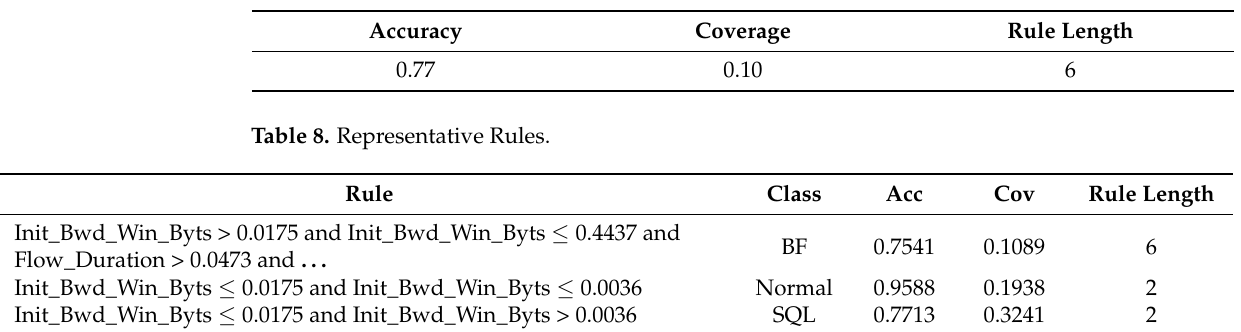
Table 7. Rule set condition.